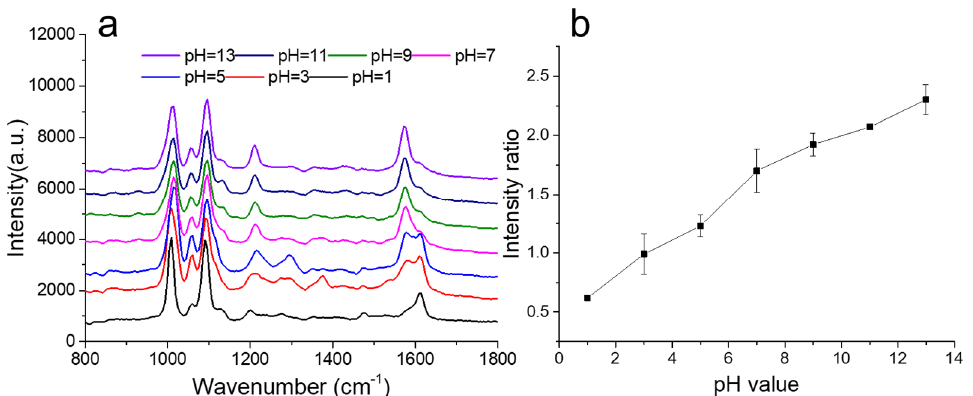
Figure 5. ( a ) SERS of 4-MPy (10 −6 M) on SiPM/Au in phosphate buffered saline (PBS) with different pH values; ( b ) the intensity ratio variation of 1574/1607 cm −1 at different pH values.